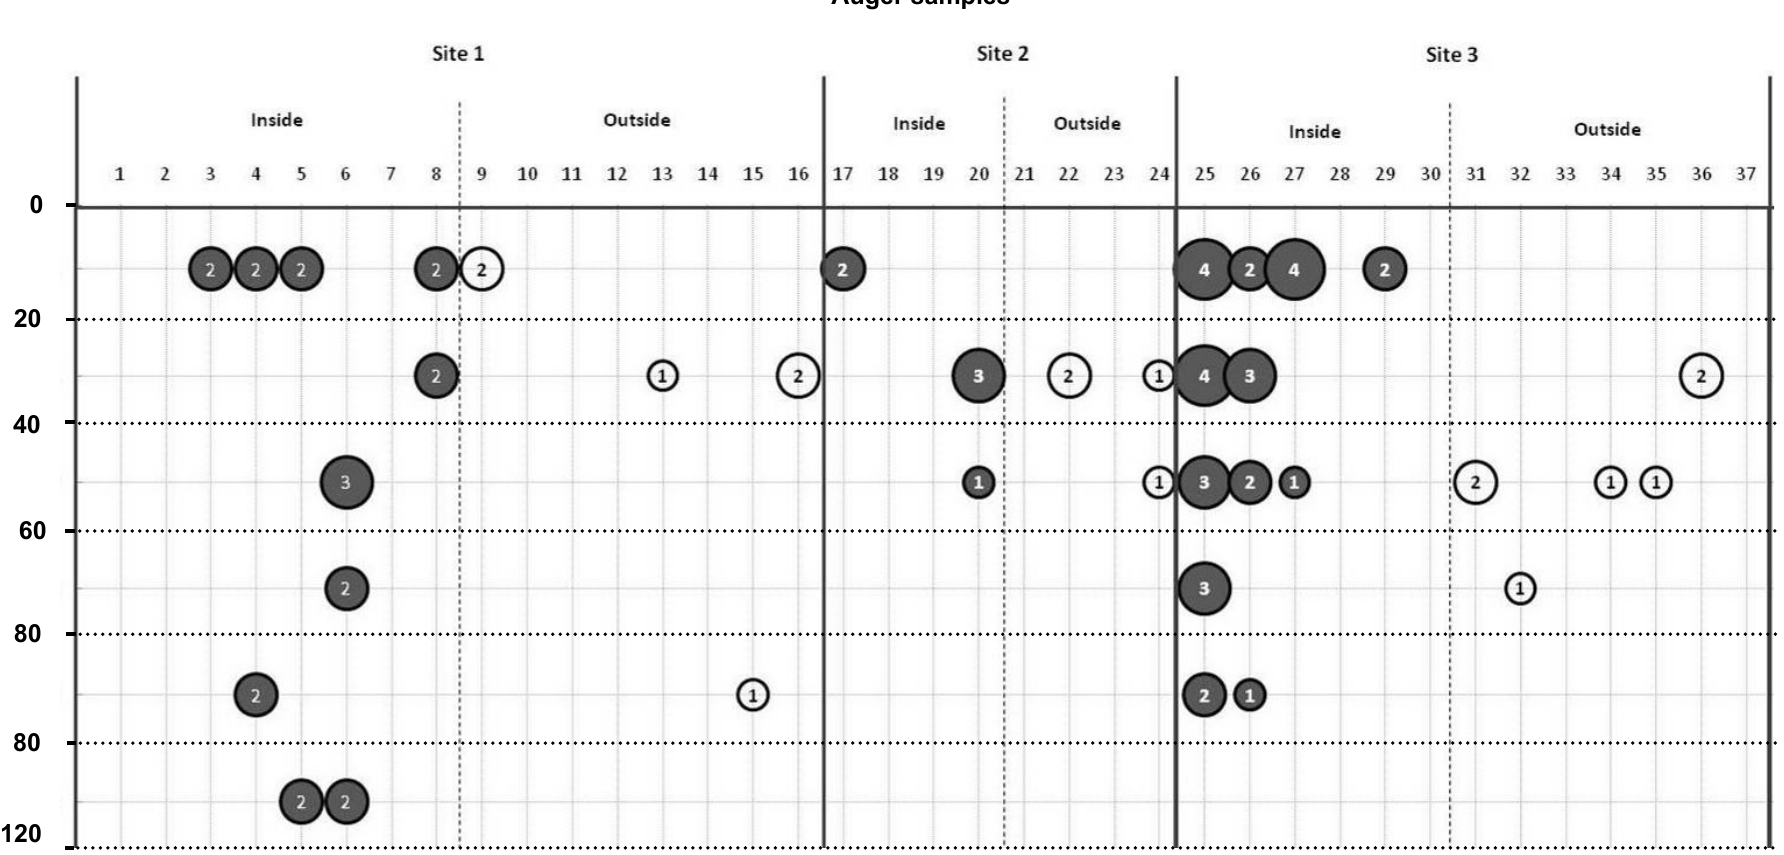
Figure 2. Abundance of the subsurface charcoal discovered in each of the 37 (identified by a number from 1 to 37) auger samples collected from the study area (southeastern Cameroon). Abundance rate 1 = rare, 2 = occasional, 3 = frequent, 4 = common, 5 = abundant. See [33] for further details on how these rates were assigned. Abundances inside and outside P. elata patches are represented by shaded and open dots, respectively. The diameter of each dot is proportional to the abundance rate. Dotted lines represent the limit between the patch and its surrounding vegetation (in columns) and the limit between two layers of soil (in